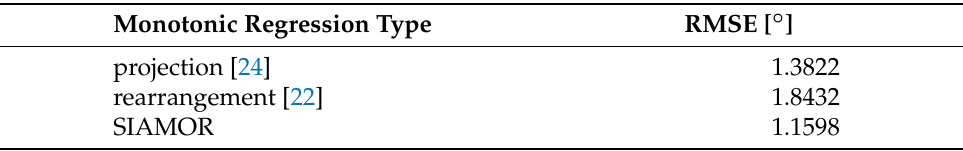
Table 3. Root-mean-squared deviations (RMSE) of the monotonic regression models from the training data for laser glass bending